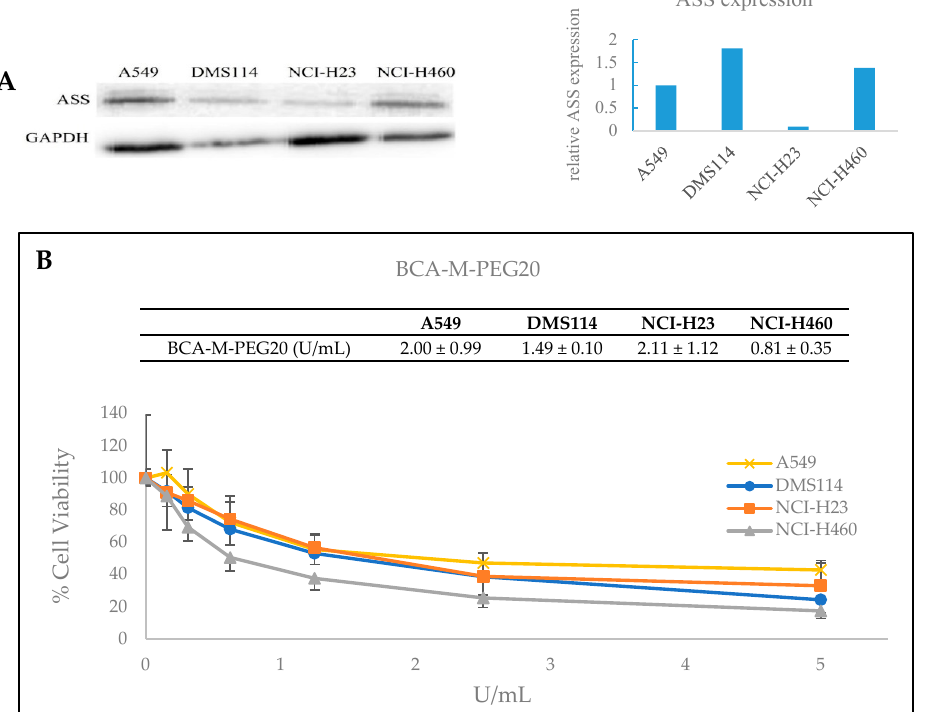
Figure 5. Western blot analysis and growth inhibitory e ff ects of BCA-M-PEG20. ( A ) The protein expression levels of ASS were determined on A549, DMS114, NCI-H23 and NCI-H460 lines. ( B ) Growth inhibitory e ff ects of BCA-M on the four cell lines. IC 50 values are given and the results are expressed as means ± S.D. Three independent experiments were performed for each cell line.